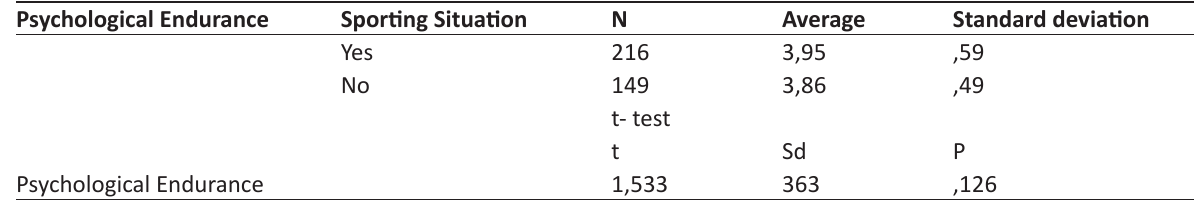
Table 1. T-test results between psychological durability score averages of individuals who do sports and who do not. Psychological